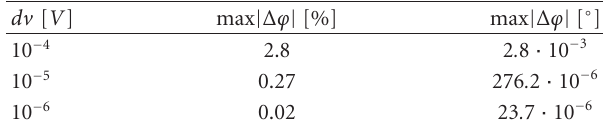
Table 1: Relative and absolute maximal phase errors.